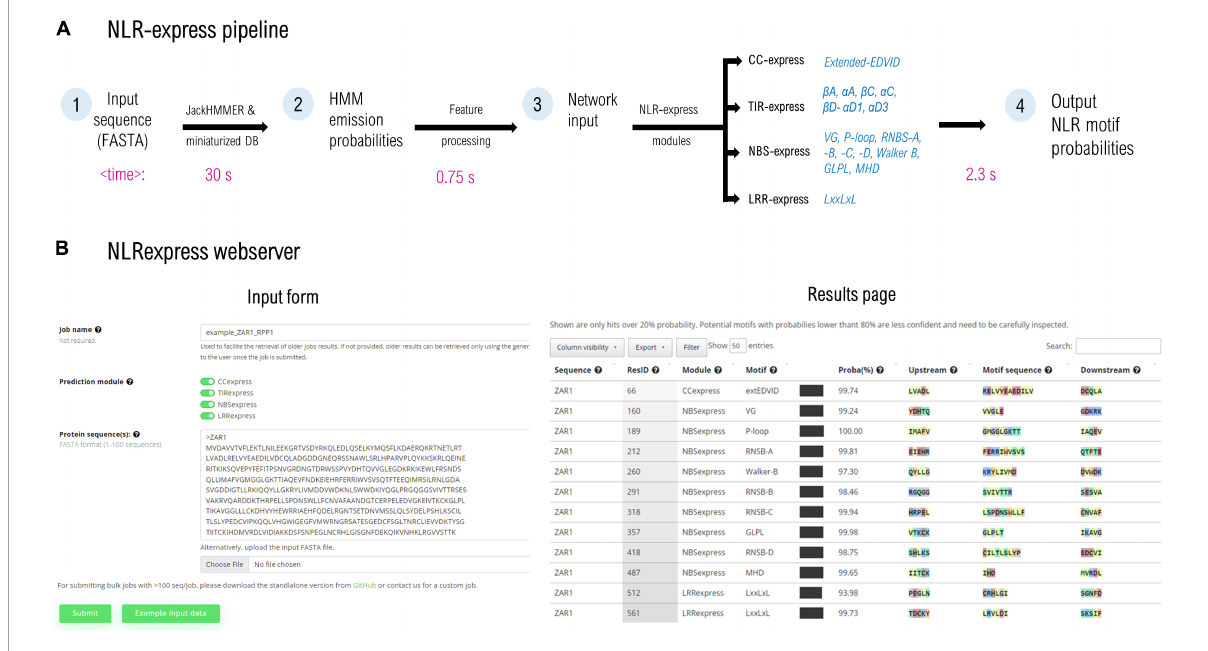
FIGURE1 (A) NLRexpress pipeline diagram with typical computation times shown below for a queried NLR sequence of average length. (B) Screen capture of the NLRexpress webserver: input form and the results page containing the prediction output. Average times may vary depending on hardware and sequence properties.